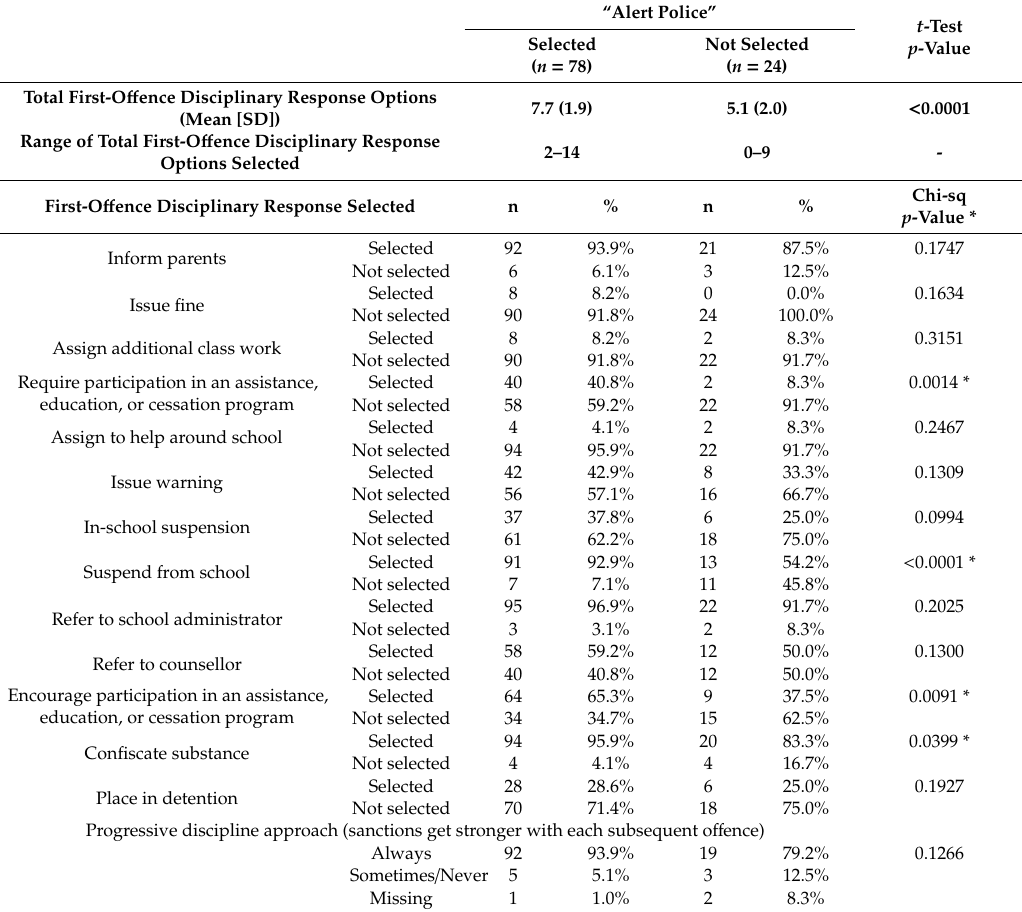
Table 3. Comparing schools in Year 6 (2017 / 2018) of the COMPASS study based on whether “alert police” was selected among options in a “check all that apply” question regarding disciplinary approach responses for first-o ff ence violations of school cannabis